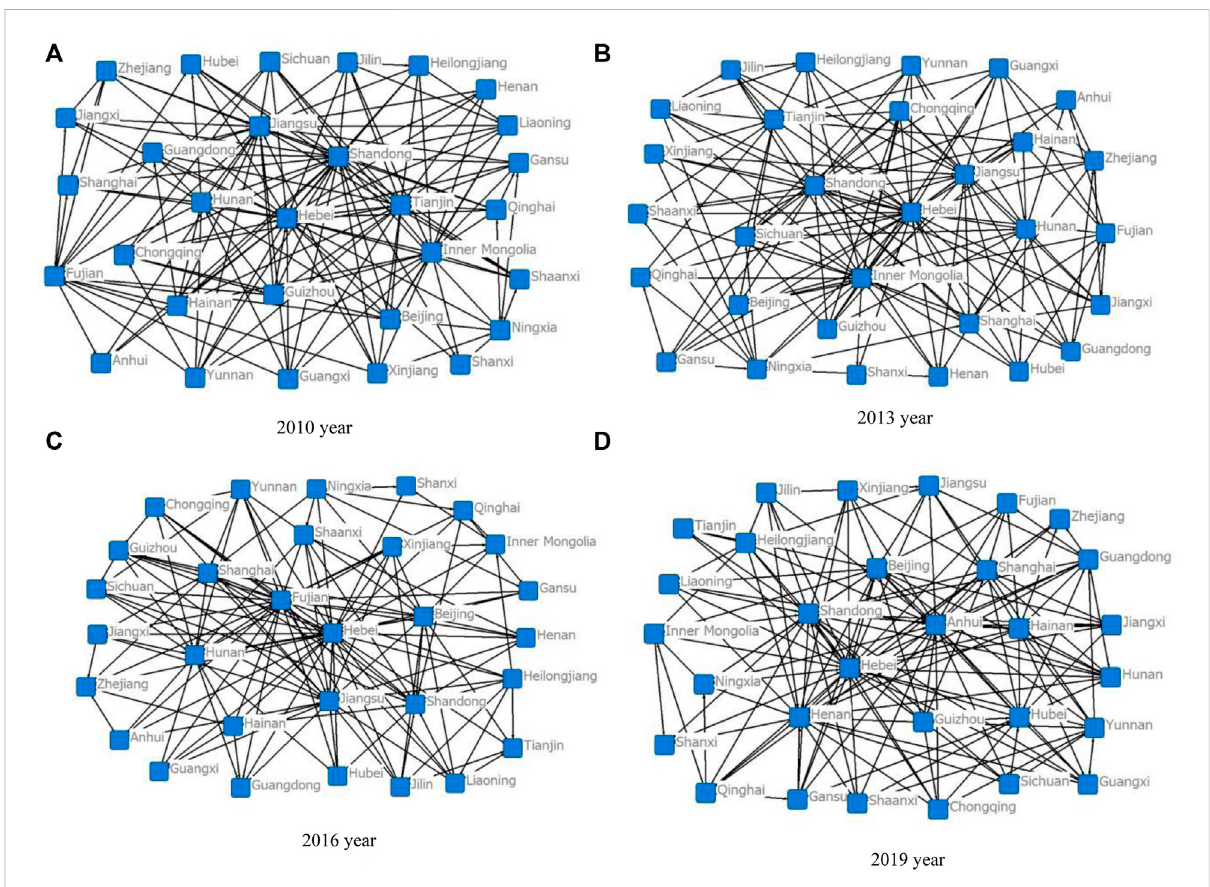
FIGURE 4 Structure of the spatial correlation network of carbon emission ef fi ciency in China ’ s logistics industry.